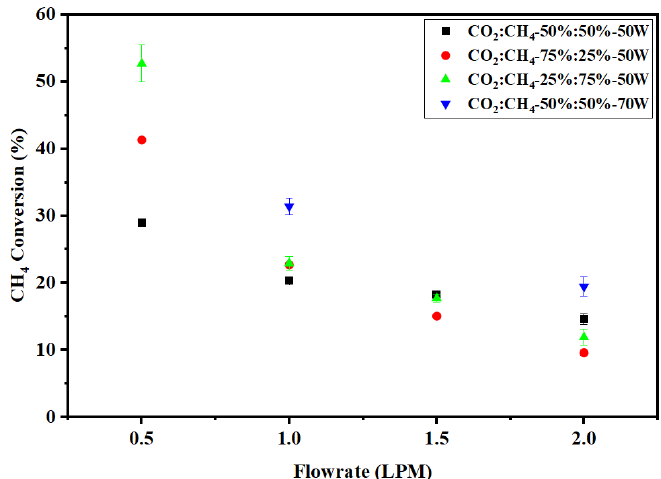
Figure 5. Effect of flow rate on CH 4 conversion.